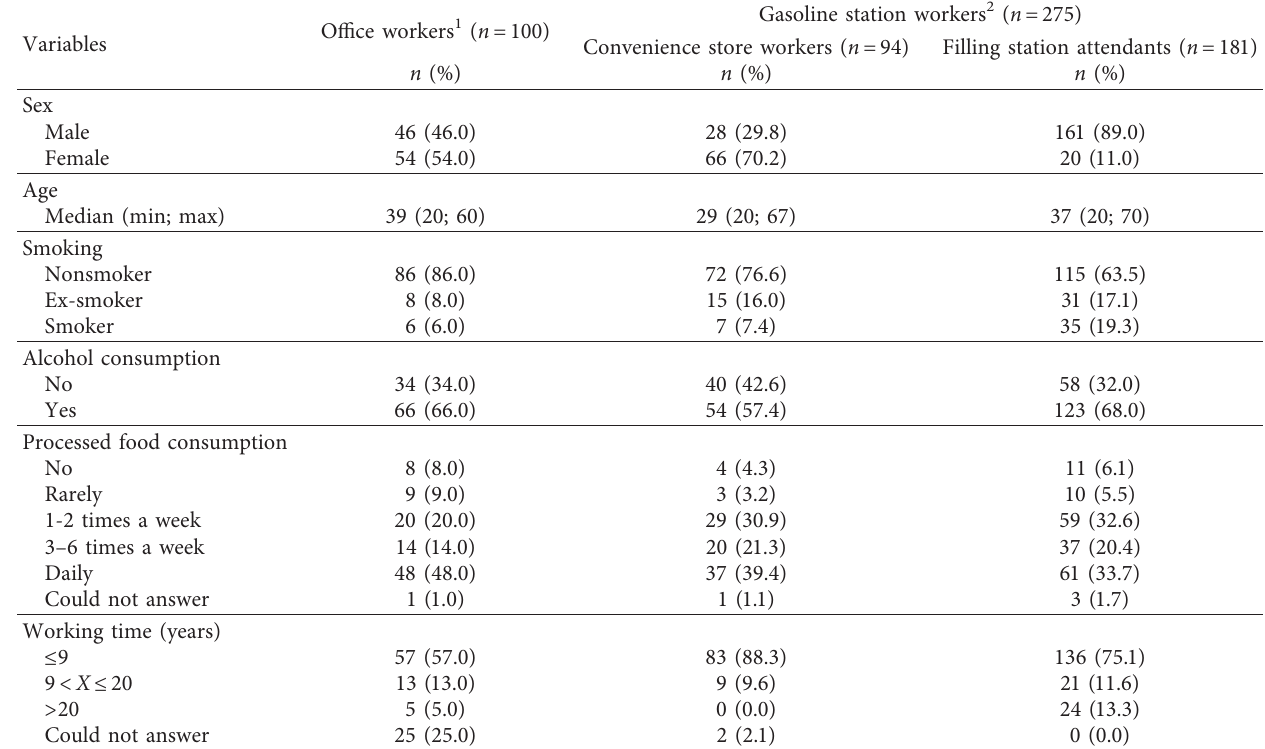
Table 1: Descriptive analysis of the sociodemographic characteristics of gasoline station workers (occupationally exposed to VOCs) and office workers (comparison group) in Rio de Janeiro (Brazil),